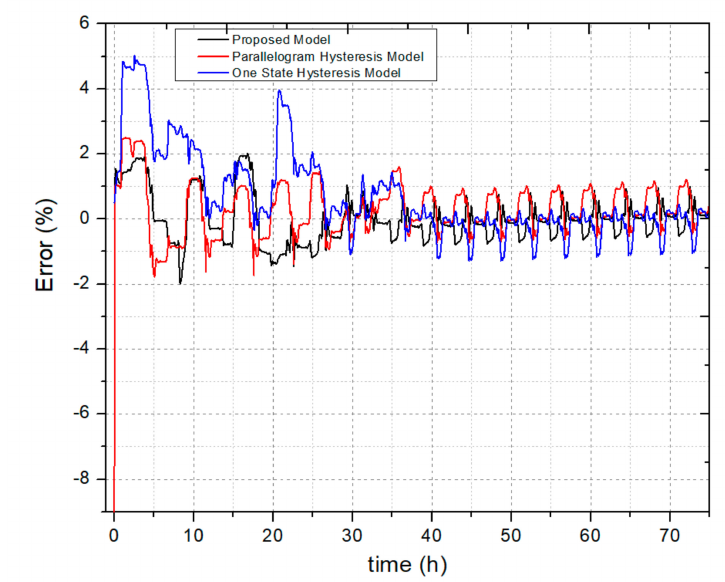
Figure 12. SOC estimation errors of three different hysteresis modeling